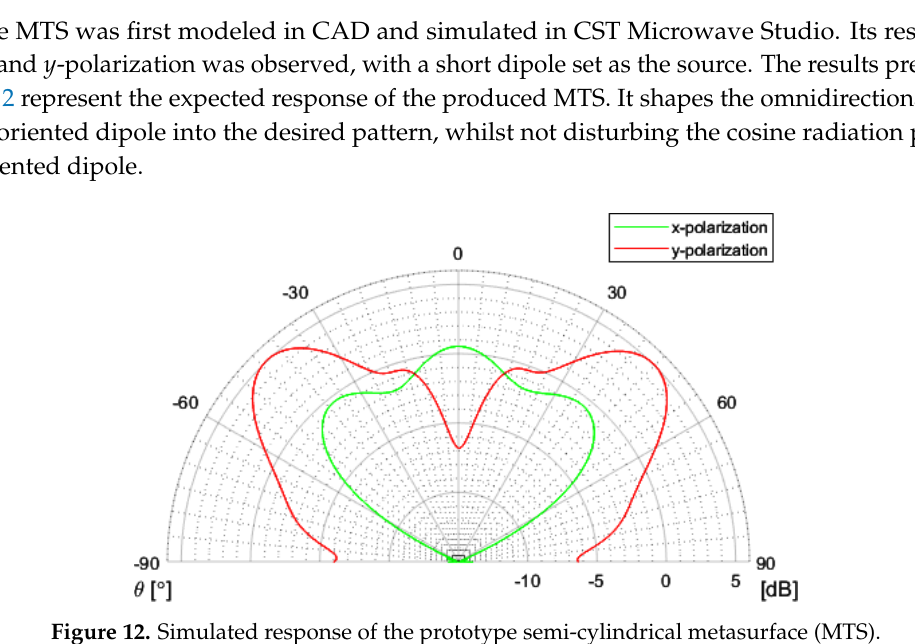
Figure 12. Simulated response of the prototype semi-cylindrical metasurface